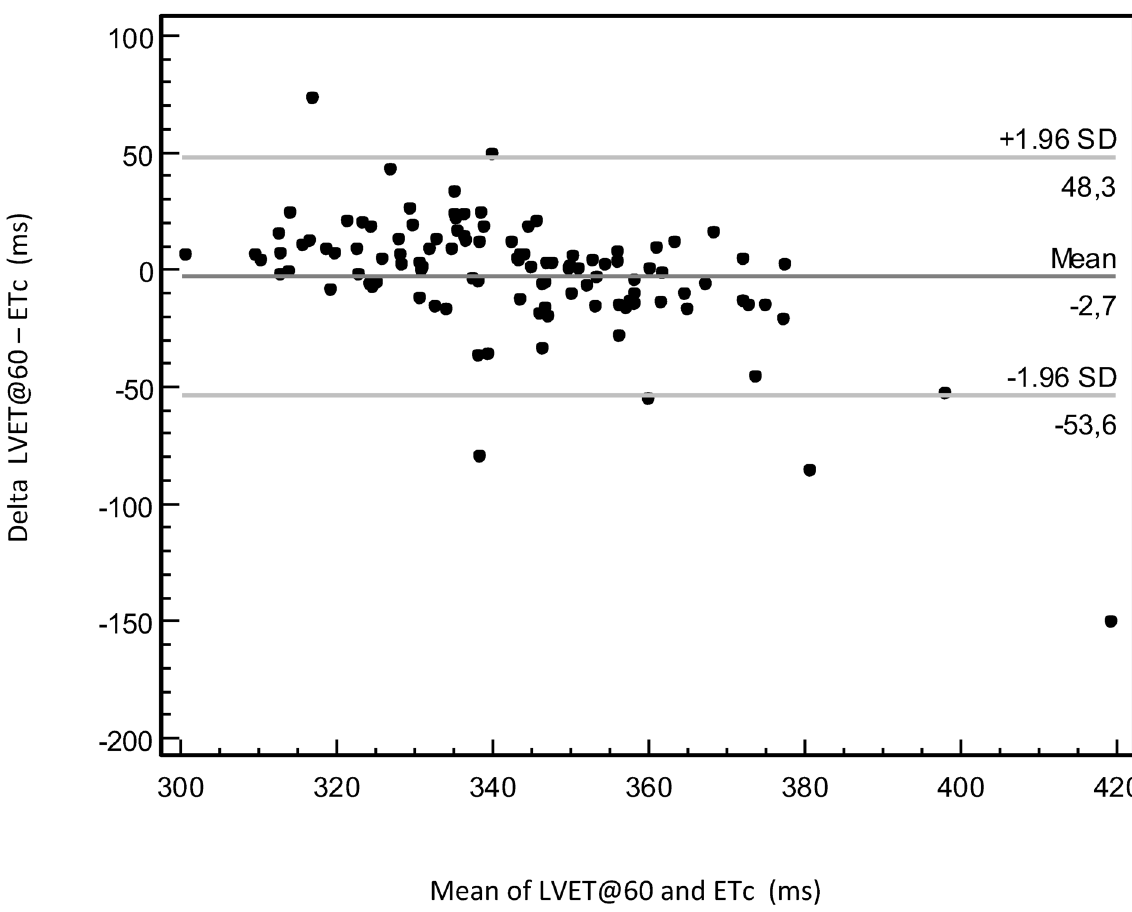
Fig 4. Agreement between ETc and LVET@60. Bland-Altman plot of left ventricular ejection time adjusted to a heart rate of 60 bpm (LVET@60) by tonometry and left ventricular ejection time compensated (ETc) by photoplethysmography, depicting the relationship of difference of measurements (Delta LVET@60 – ETc) and mean value of